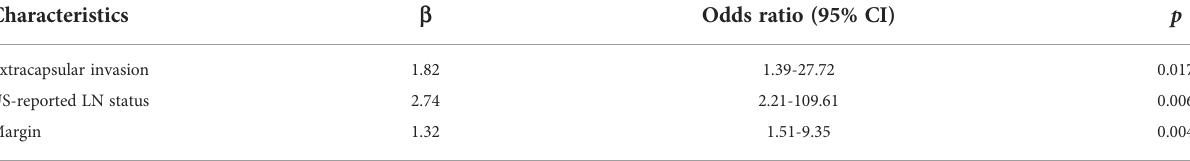
TABLE 2 Multivariate analysis of risk variables for CLNM of